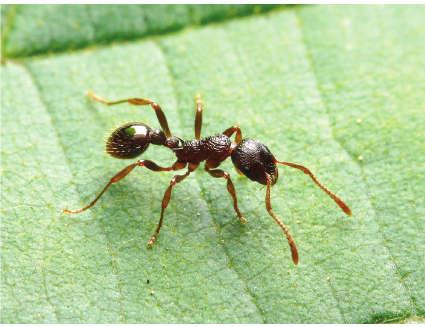
Figure 1: A worker ant of Myrmica kotokui (a photo by T.